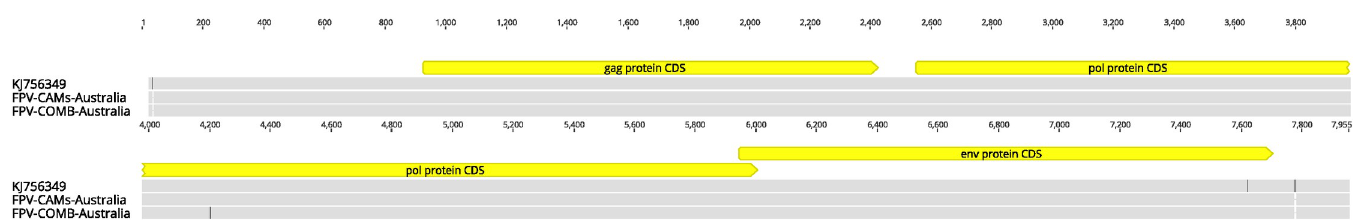
Fig 3. Comparison of near-full length provirus of REV of Australian FPV-COMB and FPV-CAMs with REV strain 104865 (KJ756349).